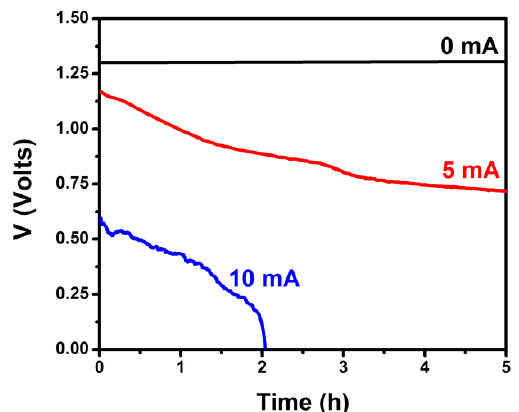
Figure 4. Variation of the voltage produced by the PFC under galvanostatic conditions by continuous illumination by a constant light intensity. The cell consisted of 2 compartments and carried a ZnS / CdSe / CdS / TiO 2 / FTO photoanode and a CB / CC cathode. The aqueous electrolytes contained 0.25 M Na 2 S and 0.125 M Na 2 SO 3 in the anode compartment and 0.5 M Na 2 SO 4 in the cathode compartment. The active area of both electrodes was 3 cm 2 .